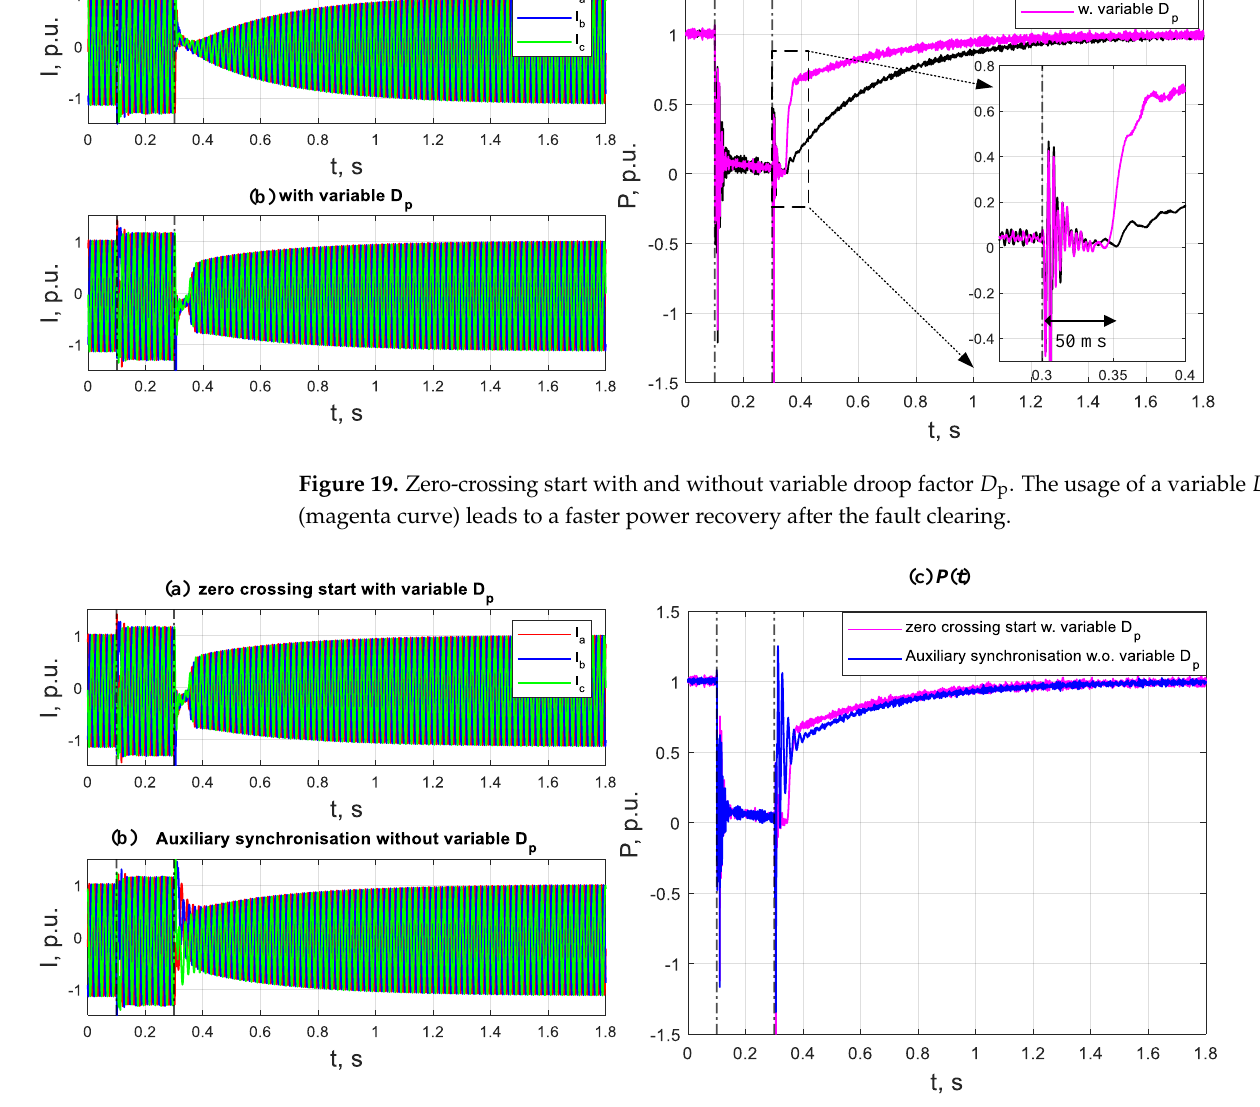
Figure 20. Zero-crossing start with variable D p , auxiliary synchronization without variable D p . The utilization of auxiliary synchronization without variable droop factor D p (blue curve) leads to similar power recovery times and avoids start-up delays.